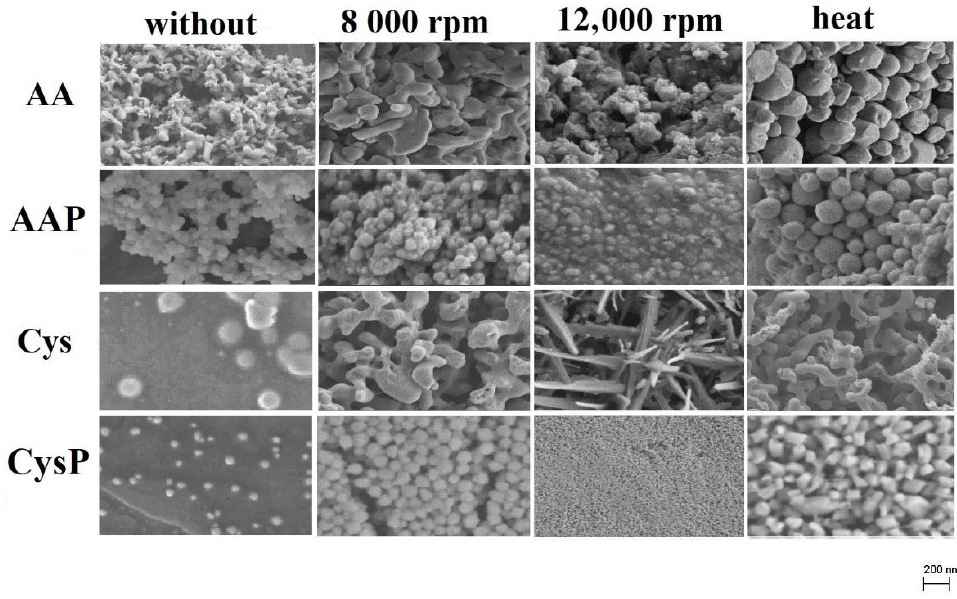
Figure 6. SEM images of the obtained SeNPs.